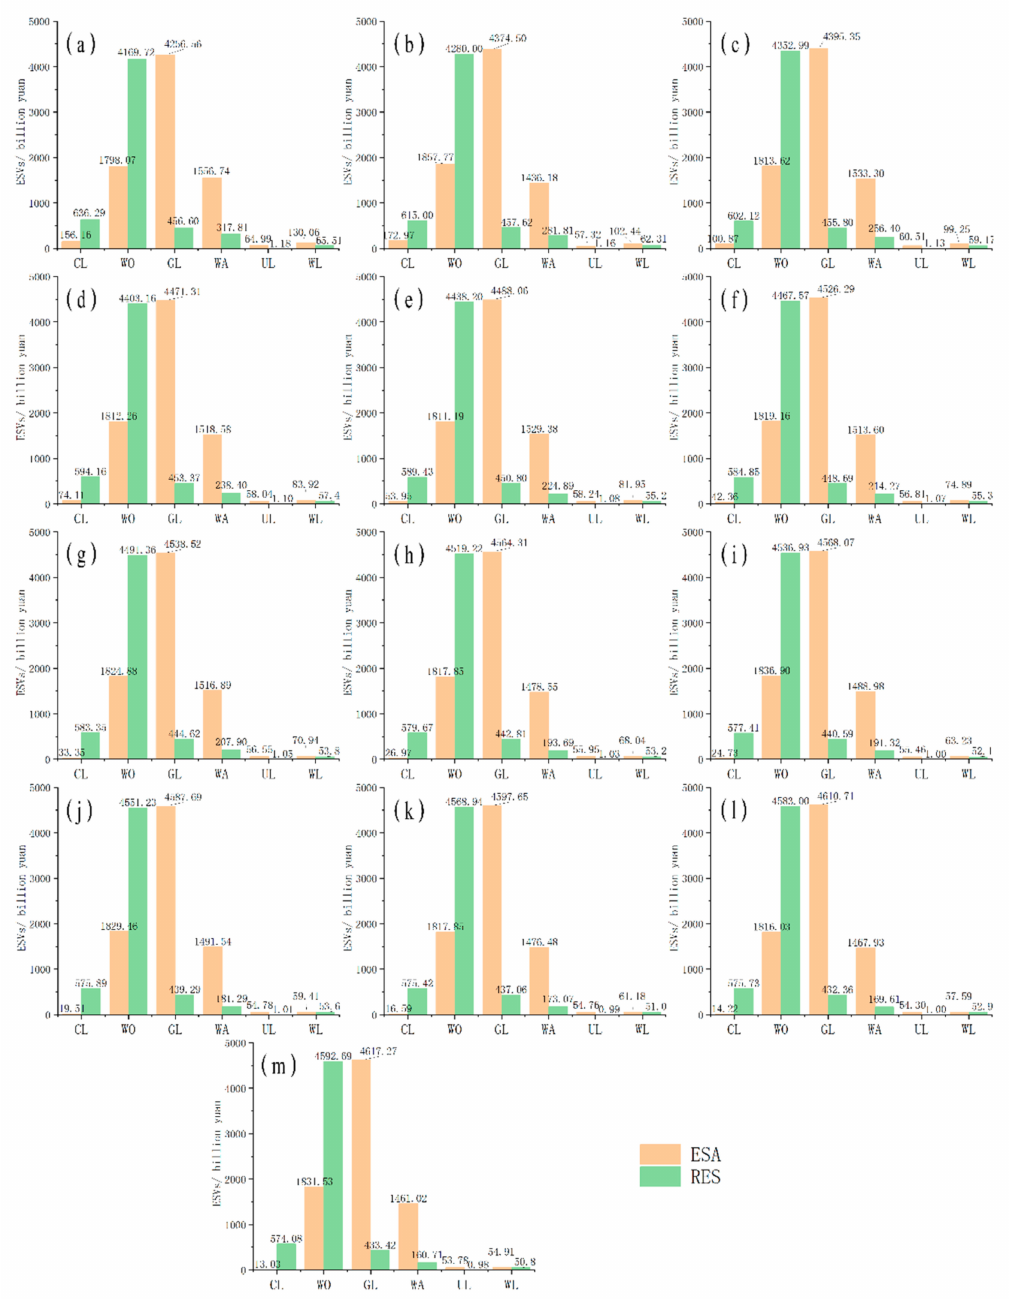
Figure 5. ESVs for all LULC types at different scales: ( a ) 300 m; ( b ) 600 m; ( c ) 900 m; ( d ) 1200 m; ( e ) 1500 m; ( f ) 1800 m; ( g ) 2100 m; ( h ) 2400 m; ( i ) 2700 m; ( j ) 3000 m; ( k ) 3300 m; ( l ) 3600 m; ( m ) 3900